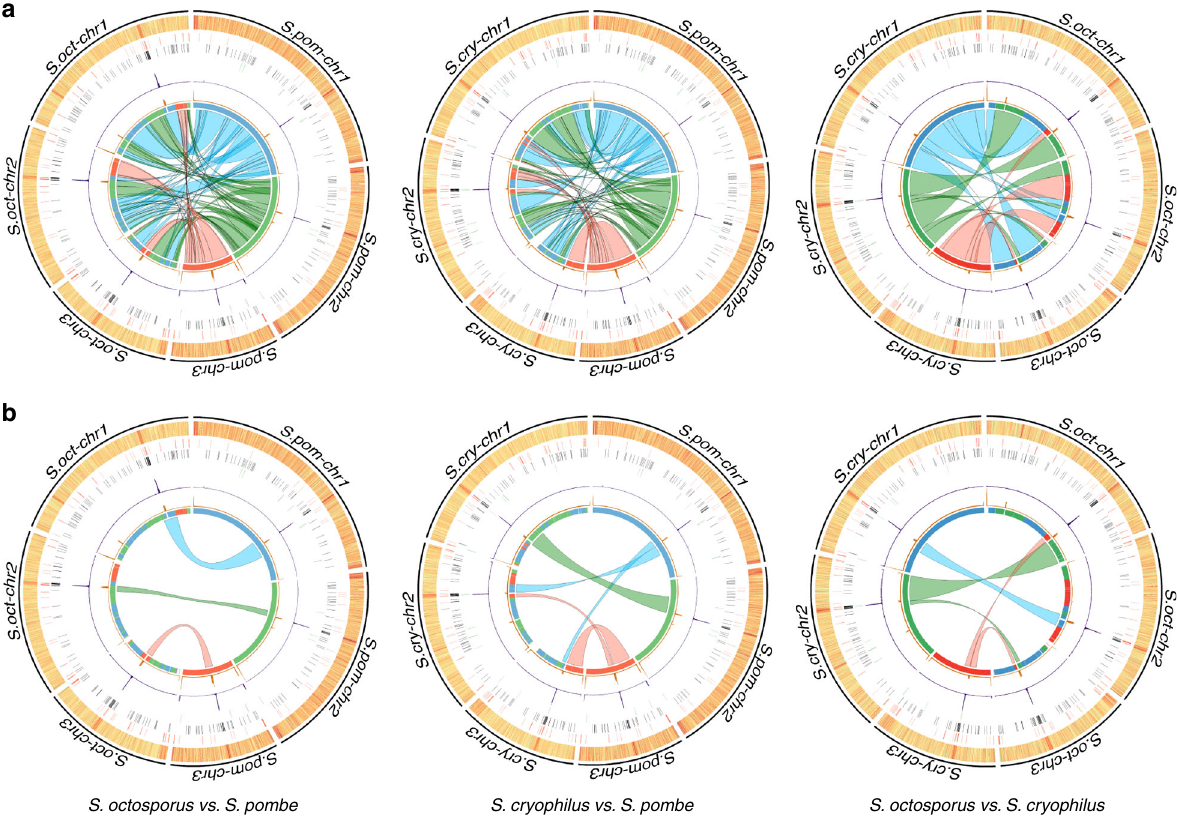
Fig. 1 Genome organization and synteny in Schizosaccharomyces . a Circos plots depicting pairwise S. pombe , S. octosporus and S. cryophilus genome synteny. Rings from outside to inside represent the following: chromosomes; GC content (high: red, low: yellow); 5S rDNAs (red); tRNA genes (black); LTRs (green); CENP-A Cnp1 ChIP-seq (purple); H3K9me2 ChIP-seq (orange); innermost ring and coloured connectors indicate regions of synteny between species. S. pombe chromosomes are indicated by blue ( S.pom-chr1 ), green ( S.pom-chr2 ), red ( S.pom-chr3 ) in the left and right panels, and regions of synteny on S. octosporus and S. cryophilus chromosomes, respectively, are indicated in corresponding colours. A similar designation is used for S. octosporus chromosomes in the middle panel. b Circos plot isolating regions adjacent to centromeres highlighting preserved synteny and an intra-centromeric chromosome arm swap involving S. cryophilus cen2 and cen3 relative to S. pombe and S. octosporus . Source data available: GEO: